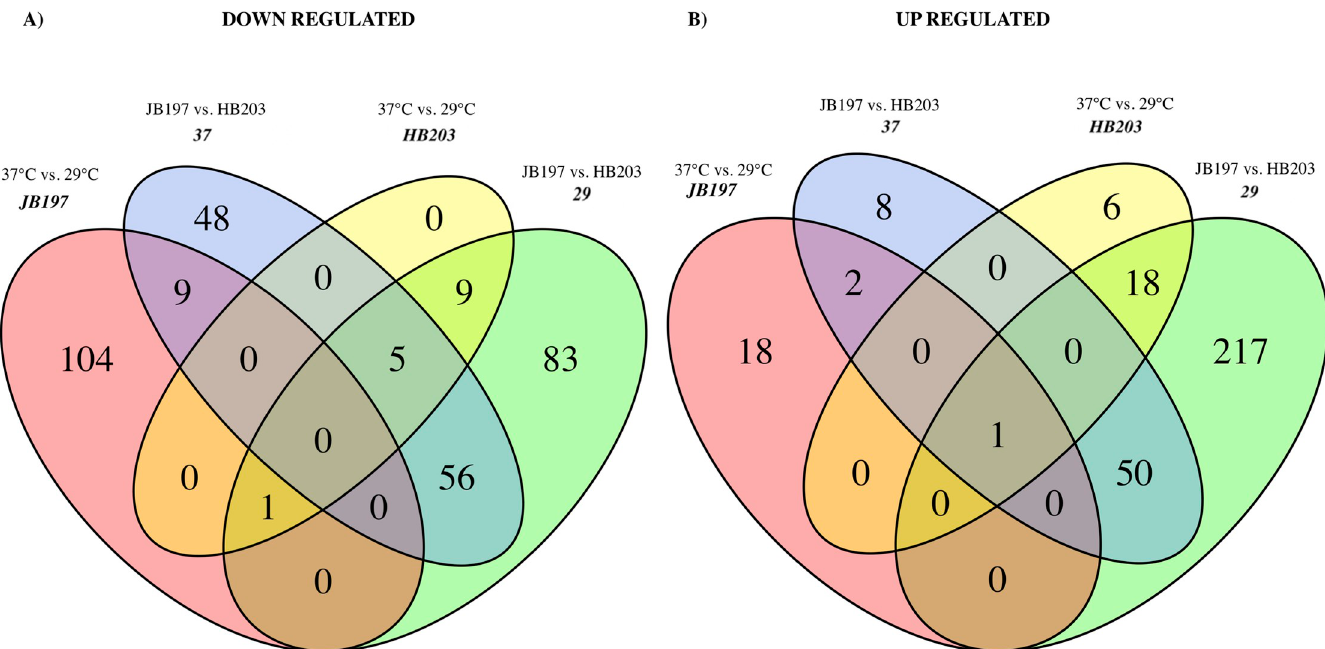
Fig 4. Venn diagram of differential expression gene profiles among the four primary contrasts of interest (label in italics); JB197 (37˚C vs. 29˚C, pink), HB203 (37˚C vs. 29˚C, yellow), 29˚C (JB197 vs. HB203, green), and 37˚C (JB197 vs. HB203, blue). Shown in panel (A) are the significantly down regulated DE genes, and (B) denotes the significantly up regulated DE